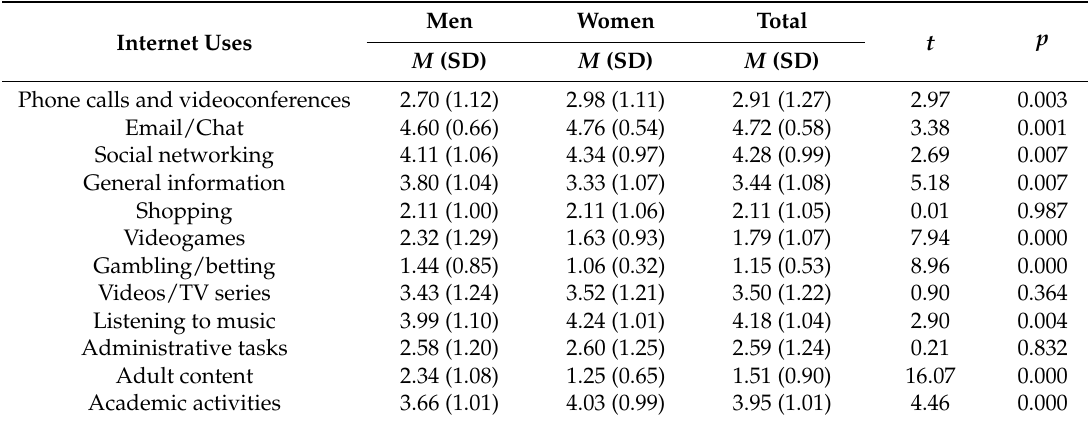
Table 1. Most frequent Internet uses by university students.